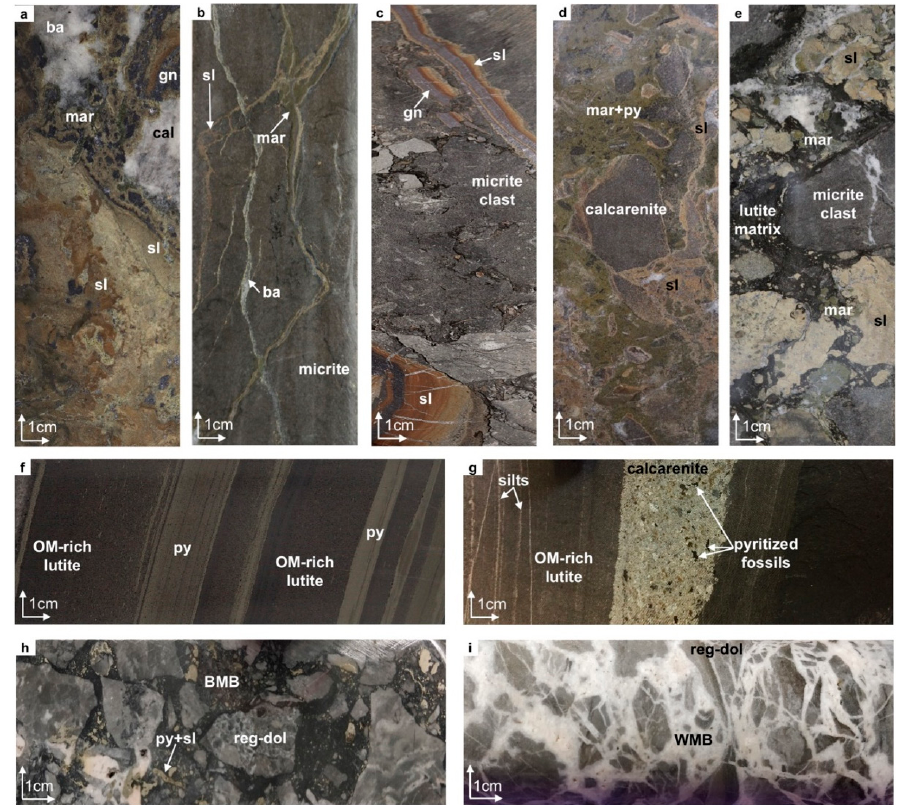
Figure 3. Main host facies and mineralization styles at Tara Deep ( a – e ), in the Upper Dark Limestone overlying Tara Deep ( f , g ) and breccia types at Lisheen ( h , i ). ( a ) High grade mineralization comprising massive sphalerite (sl), galena (gn) and marcasite (mar) with late barite (ba) and calcite (cal), replacing the host micrite; ( b ) low grade mineralization displaying marcasite, barite and sphalerite veining; ( c ) low grade mineralization formed by reworked micrite partially replaced by alternating layers of sphalerite and galena; ( d ) mineralized conglomerate comprising micrite clasts with sphalerite, marcasite, and pyrite (py) filling open spaces; ( e ) brecciated sphalerite mineralization hosted within disrupted Pale Beds-rich conglomerates; ( f ) organic matter-rich lutite replaced by ~0.5 to 1.5 cm layers of fine-grained pyrite parallel to bedding; ( g ) alternating sequences of organic matter-rich lutites, silts and